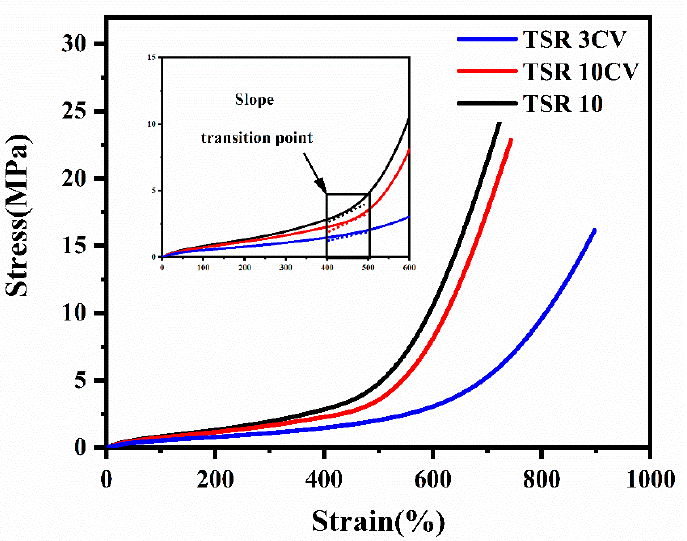
Figure 3. Stress-strain curves for rubber vulcanizates for TSR 10, TSR 10CV and TSR 3CV.